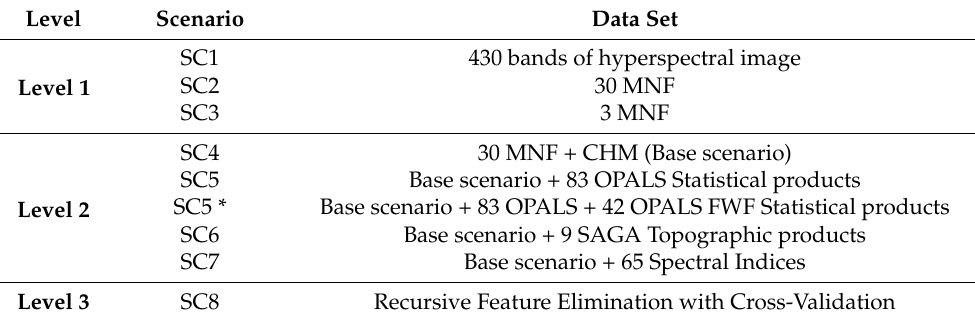
Table 2. Data sets used in a given classification scenario. MNF: Minimum Noise